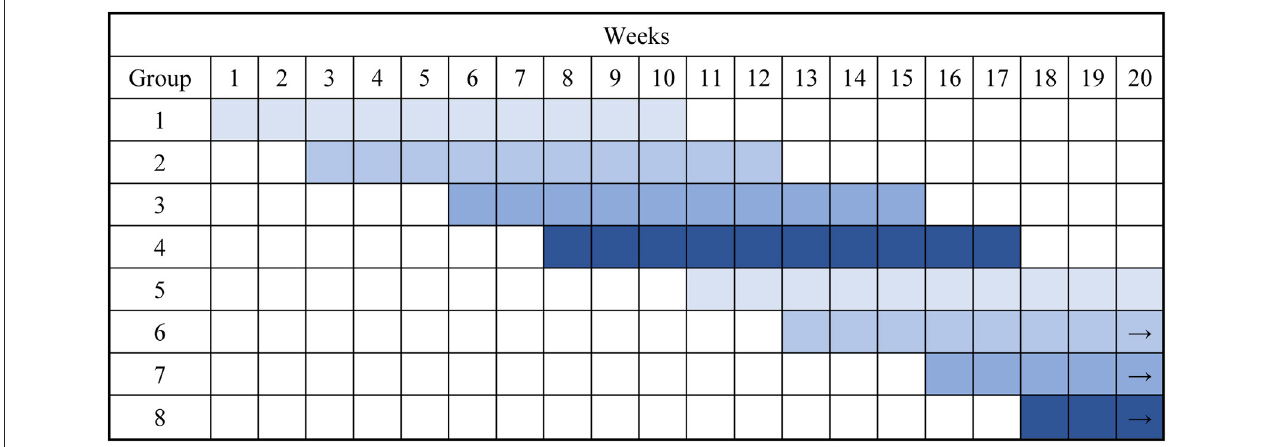
Frontiers in Public Health |